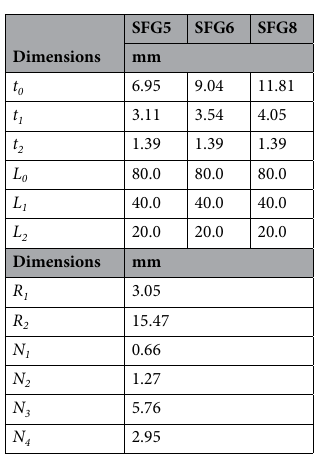
Table 1. The dimensions for the grids and the net in Fig.